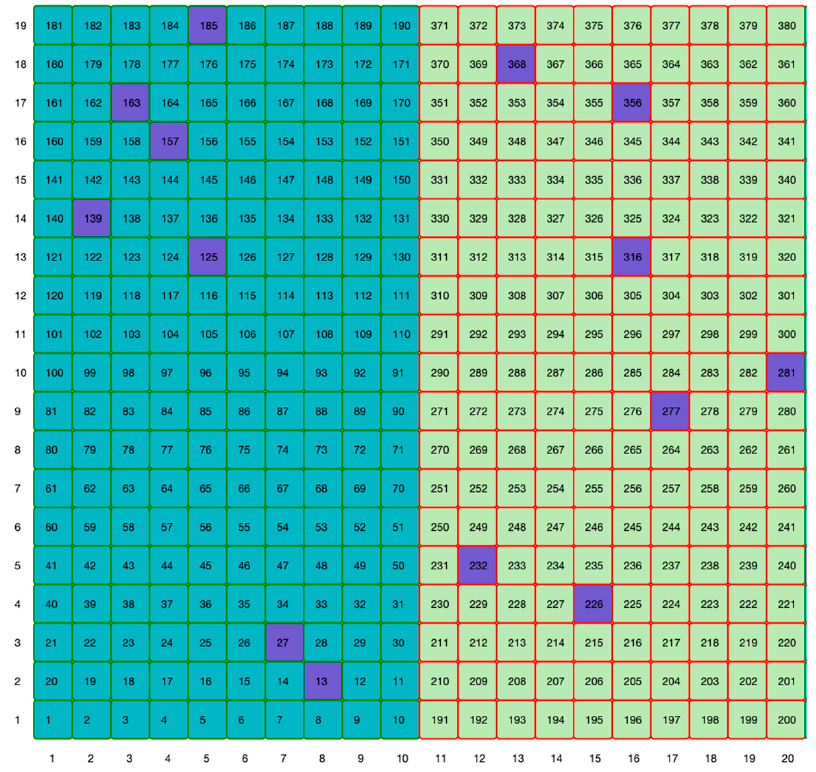
Figure 3. Field Map. The purple shading indicates the location of the experimental checks (control cultivars). The teal and olive colors show the different replications. The X and Y axis correspond to the field column (longitude) and field row (latitude), respectively, and are used to reference the field plot.